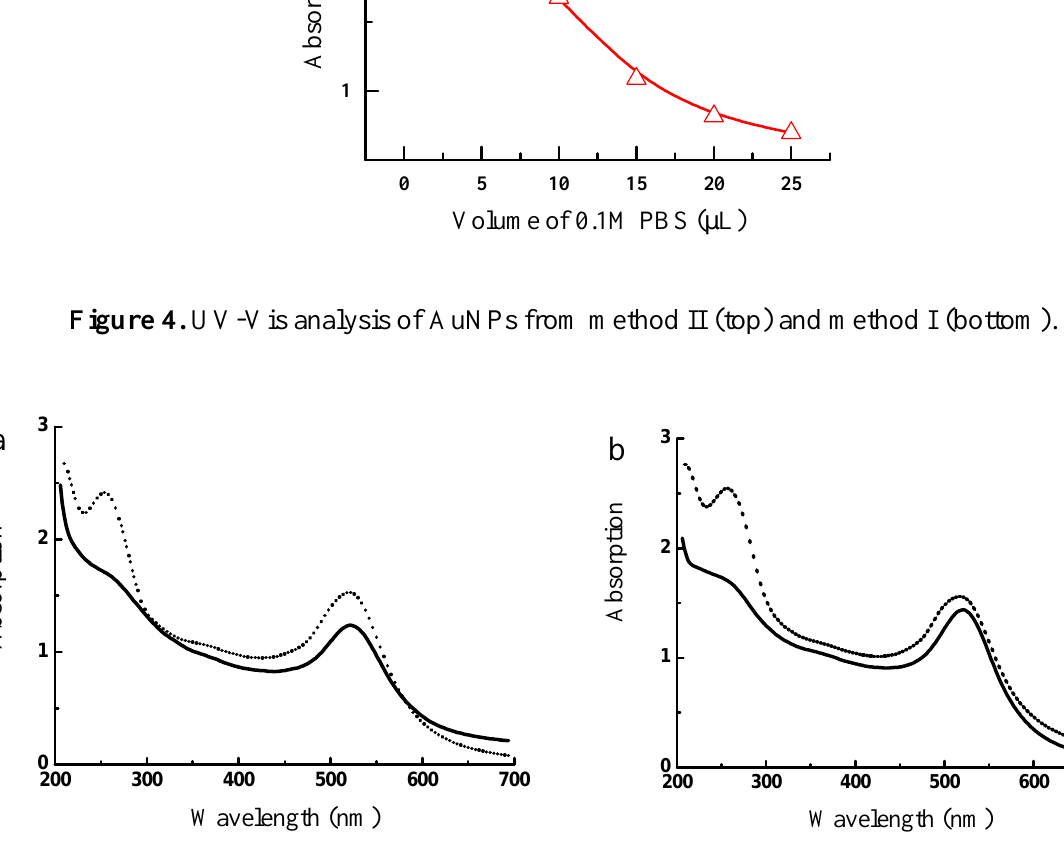
Figure 5. UV-Vis spectra of AuNPs-DNA before (dashed line) and after (solid line) centrifugation. a) method I; b) method